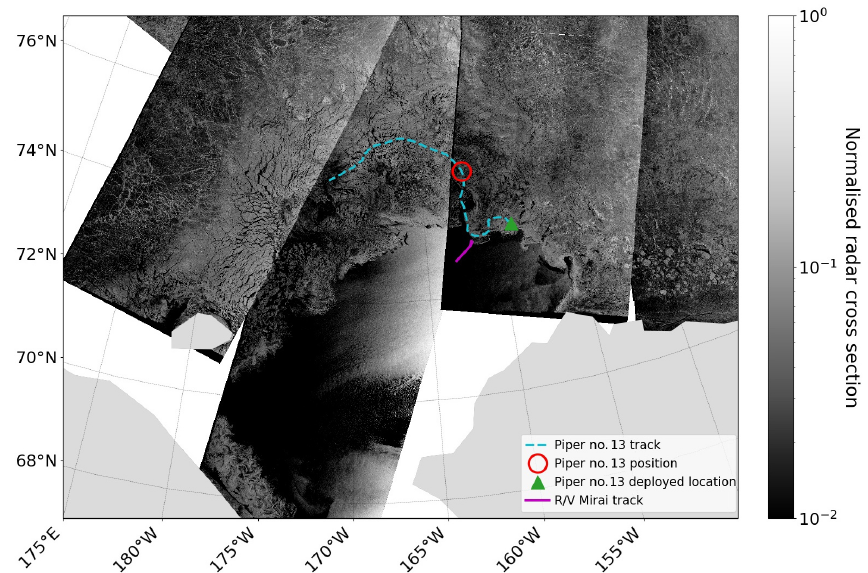
Figure 1. Observation locations are overlaid on the mosaic of Sentinel-1 normalised radar cross section (NRCS) images (NOAA, 2019) acquired on 15 November 2018. The R/V Mirai track on this date is shown as the solid magenta line, and the Piper no. 13 drifting wave buoy track between 6 and 28 November is shown as the dashed cyan line. The green triangle shows the deployment location, and the red circle represents the buoy position on 15 November,